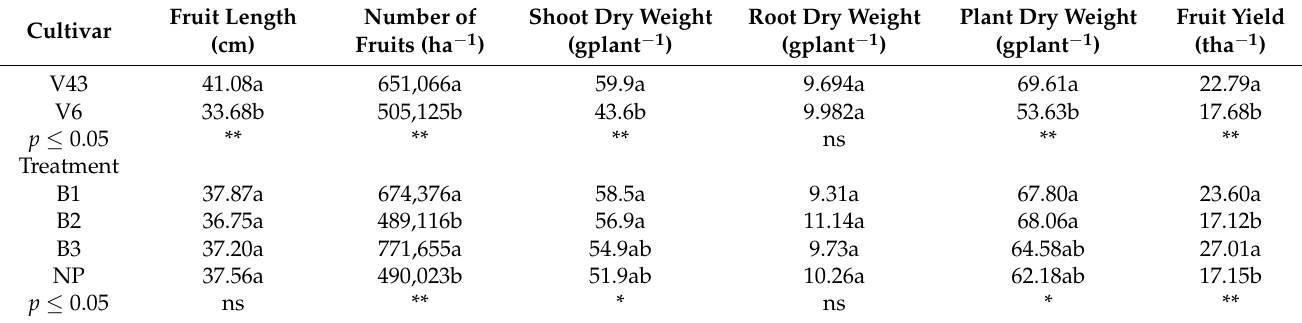
Table 3. Yield and biomass of cayenne pepper cultivars in response to PGPR and chili residue.